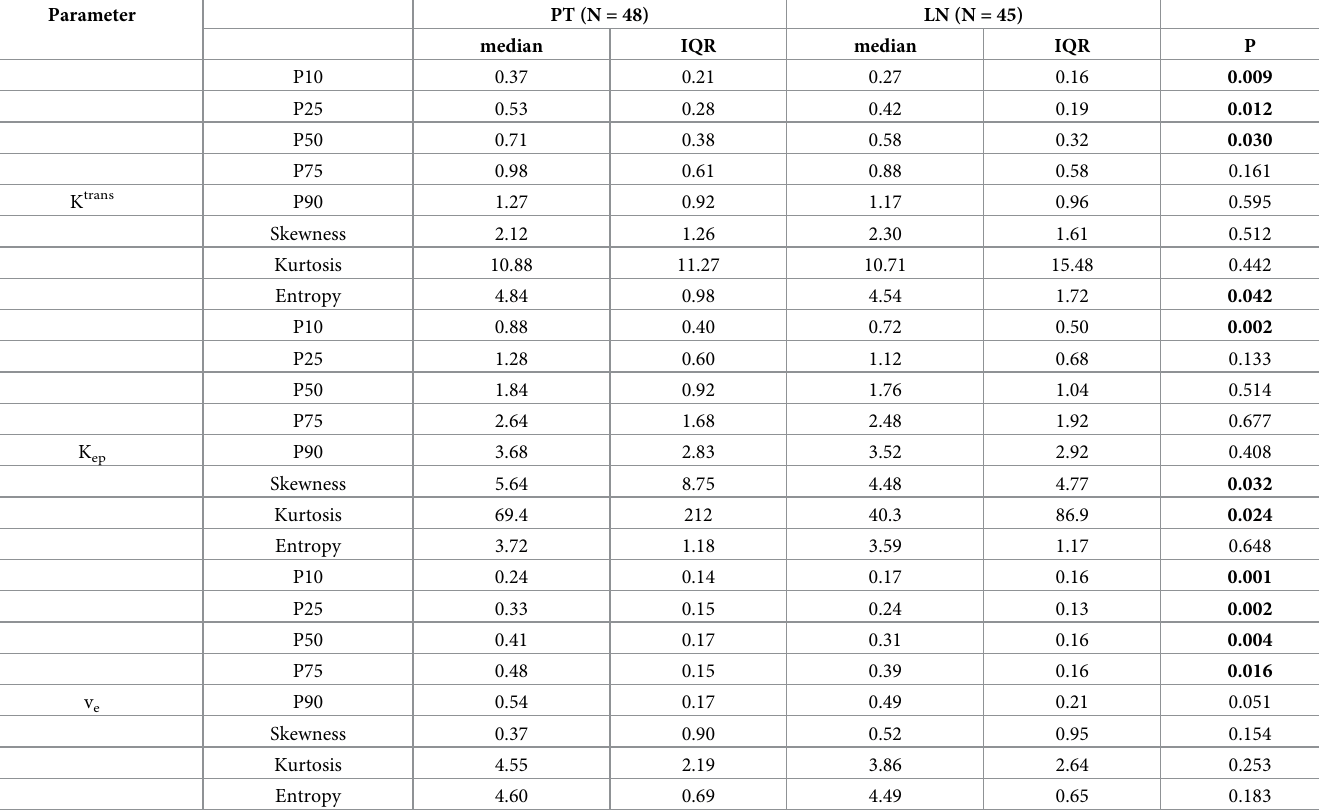
Table 2. Summary statistics of DCE-MRI parameters in primary tumors (PTs) and metastatic lymph nodes (LNs). Parameter